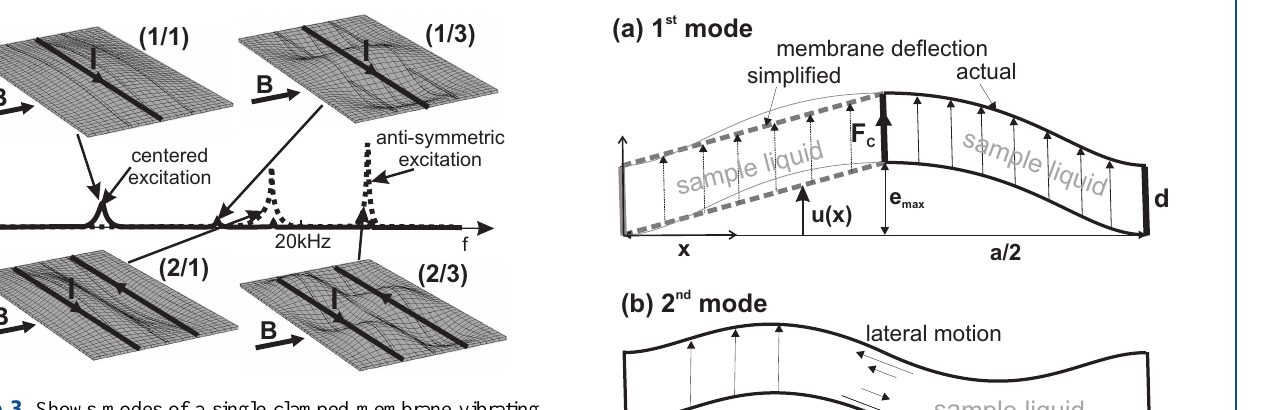
Figure 3. Shows modes of a single clamped membrane vibrating in vacuum - the numeric simulation is done with Comsol 4.1. The dashed line describes the response of the membrane to the excitation by the two excentric paths, where the (2 / 1) and the (2 / 3) modes are driven. Applying a harmonic current to the center–path excites the (1 / 1) and the (1 / 3) modes. Figure 4. Qualitative two–dimensional flow between the two membranes, when vibrating antisymmetrically in the first (a) and in the second mode of vibration, (b).